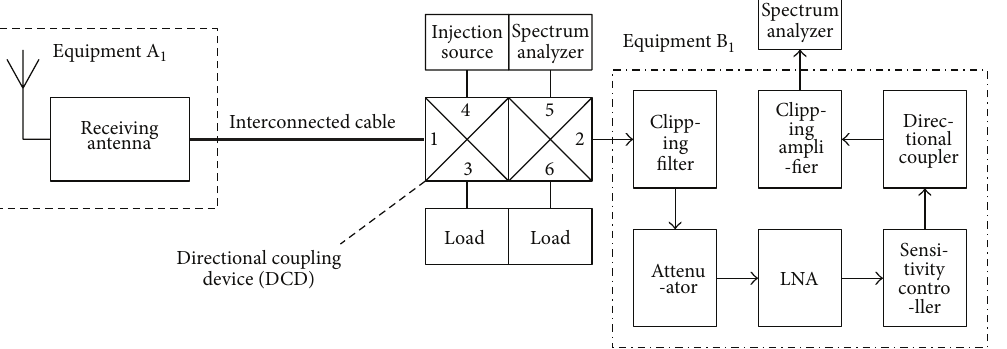
Figure 13: The configuration diagram for the differential-mode current injection